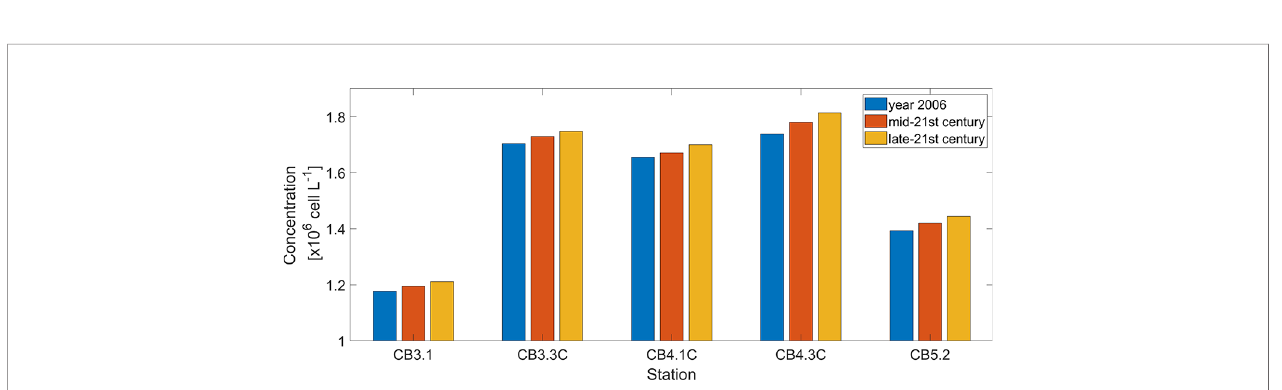
FIGURE 9 | Comparison between peak P. minimum cell concentration during the spring bloom in May of year 2006, mid-21st century, and late-21st century at 5 mainstem stations marked in Figure 2A